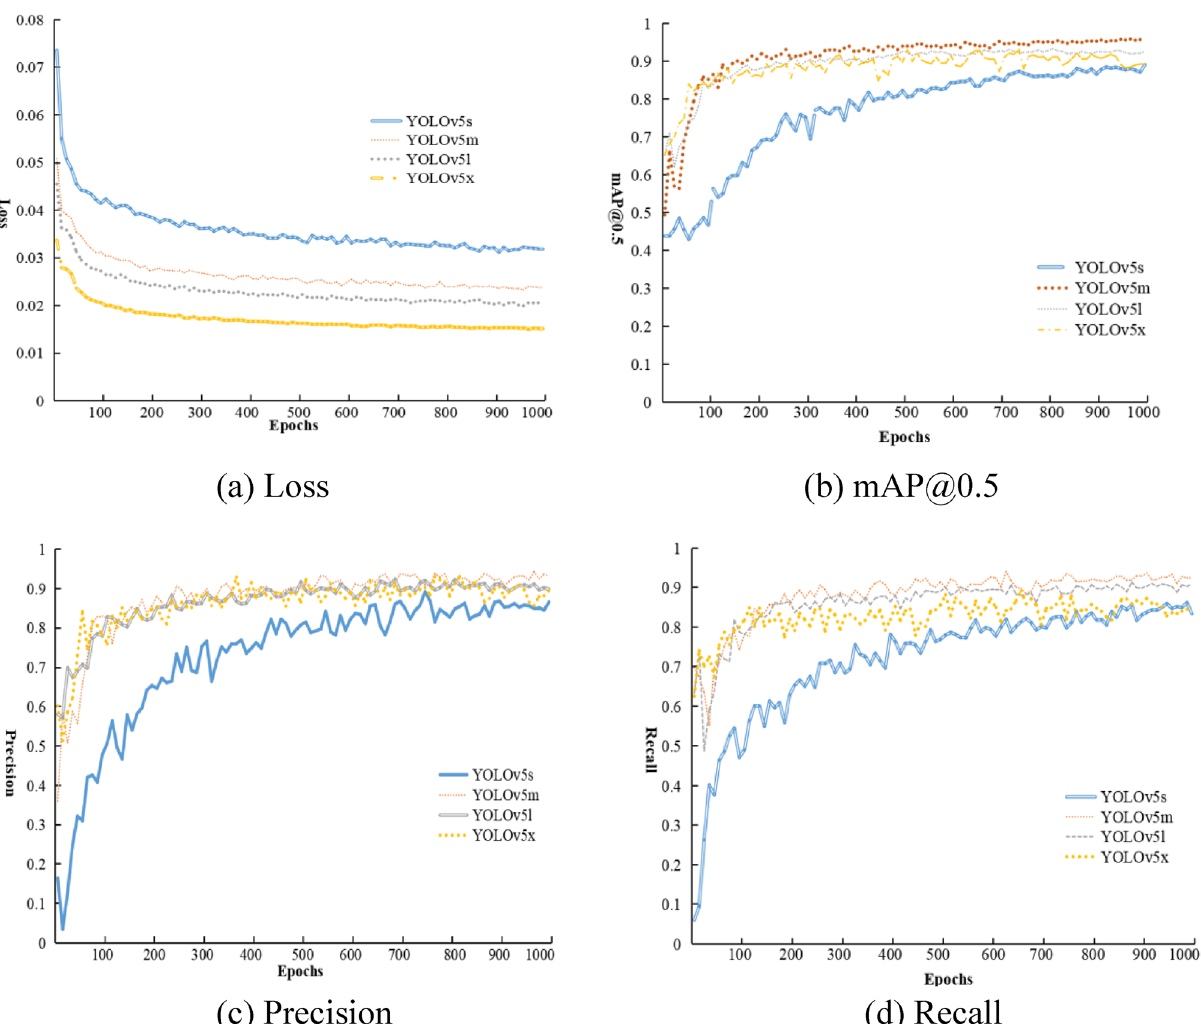
Figure 2. Training process of four pretrained